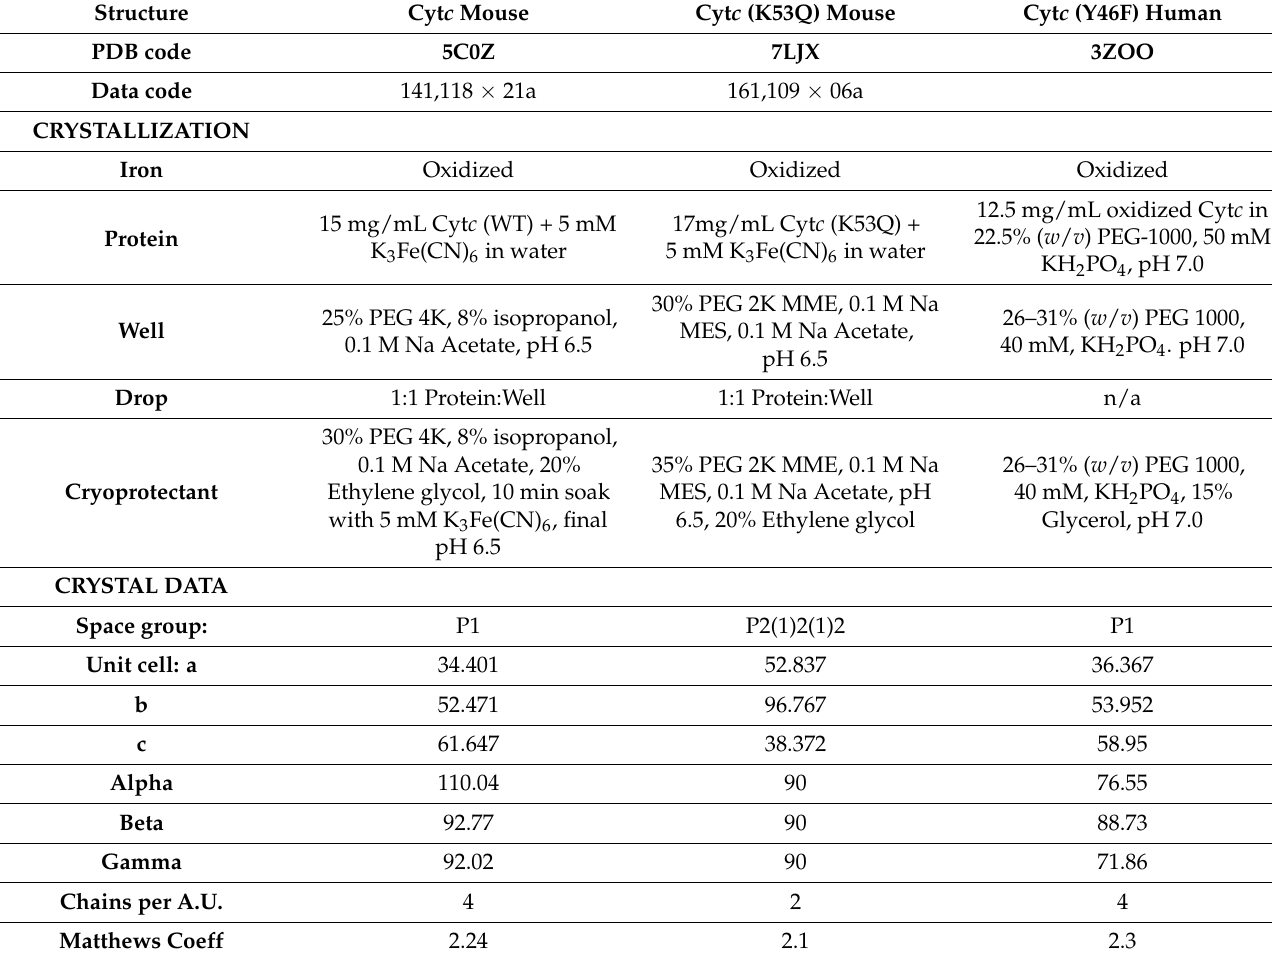
Table 1. Crystallographic data summarizing and comparing three structures of cytochrome c : Native, K53Q, and human Y46F.